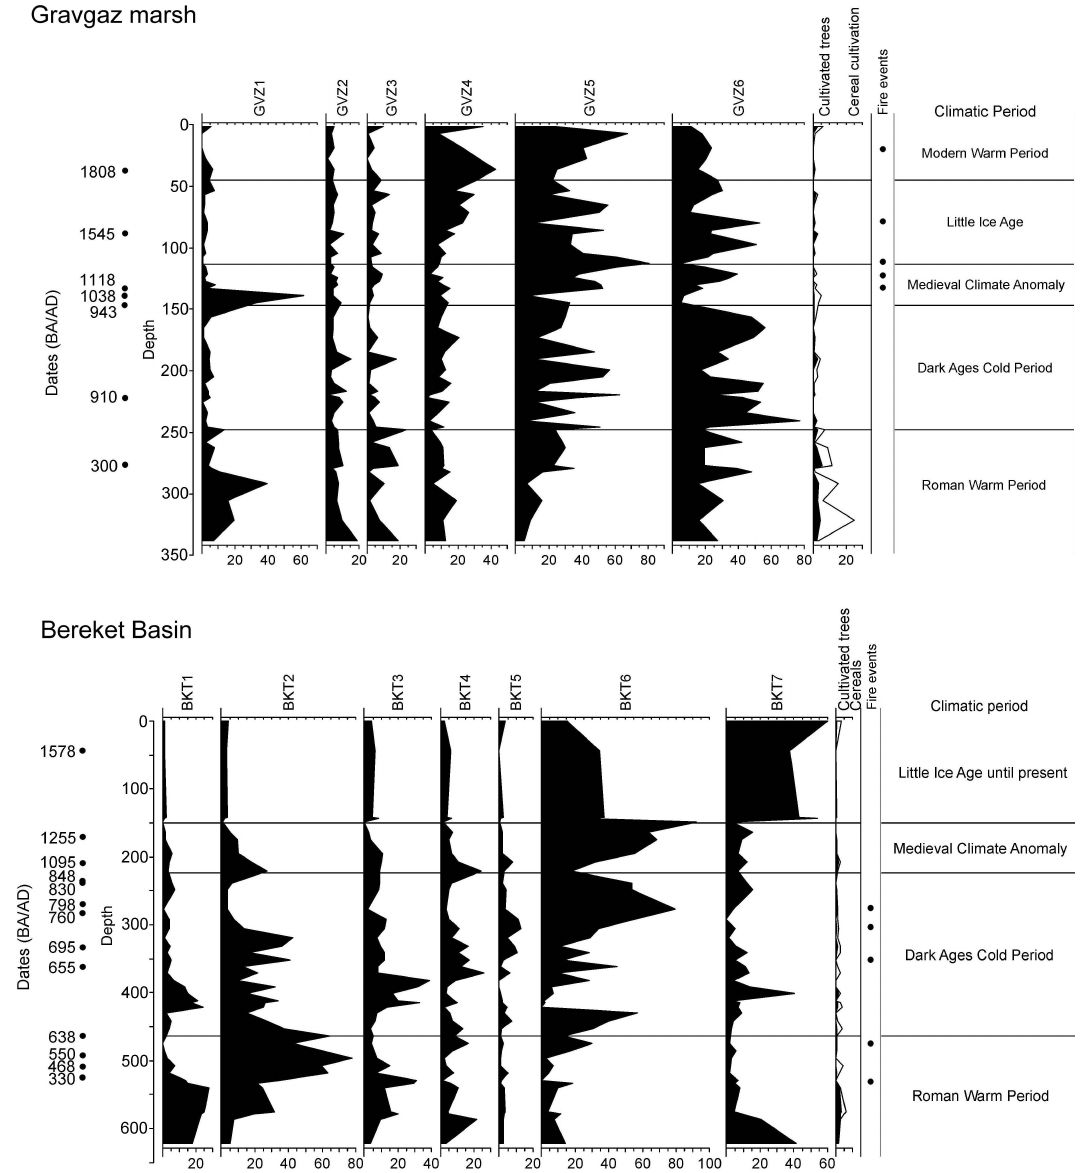
Fig. 7. Summary pollen diagrams displaying the total pollen percentage for each PDVP, and the fire events as detected by CharAnalysis, displayed along a depth